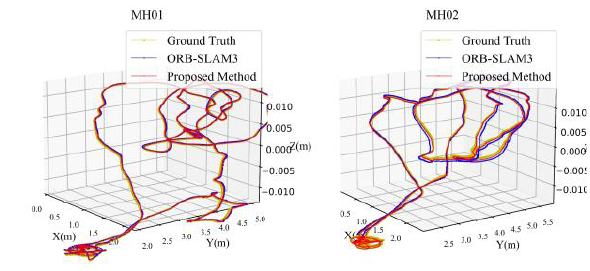
Figure 3. Frame trajectories in the mono-inertial